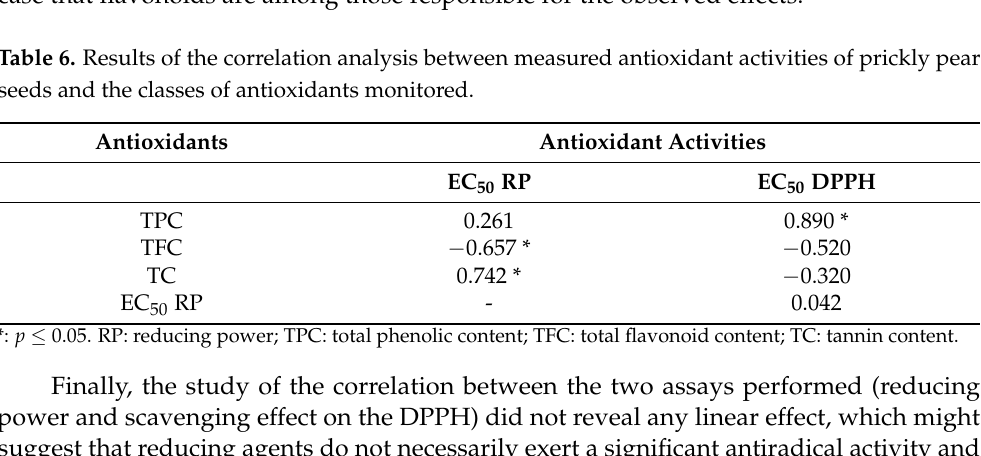
phenols mixture; Figure S2: Representative HPLC chromatograms of O. ficus-indica seed extract at 280